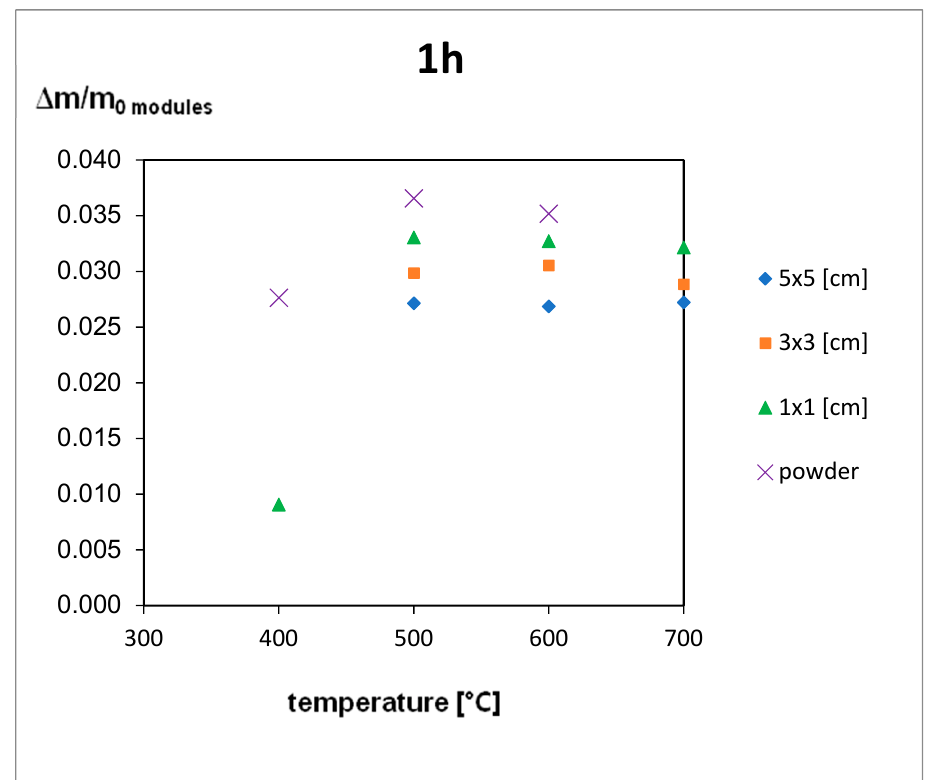
Figure 5. Results of the thermal treatment of module pieces for 1 h. Materials 2019 , 12 , x FOR PEER REVIEW